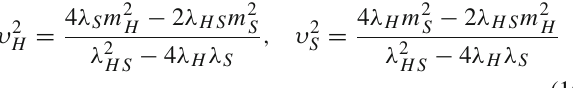
corrections in h 1